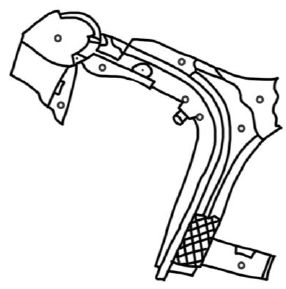
Figure 34. US Patent 3,468,582 Honeycomb structure [16].